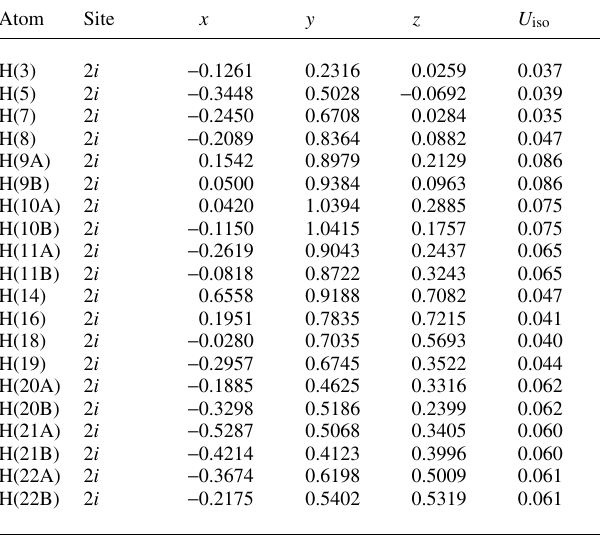
Table 2. Atomic coordinates and displacement parameters (in Å 2 ) . Atom Site x y z U